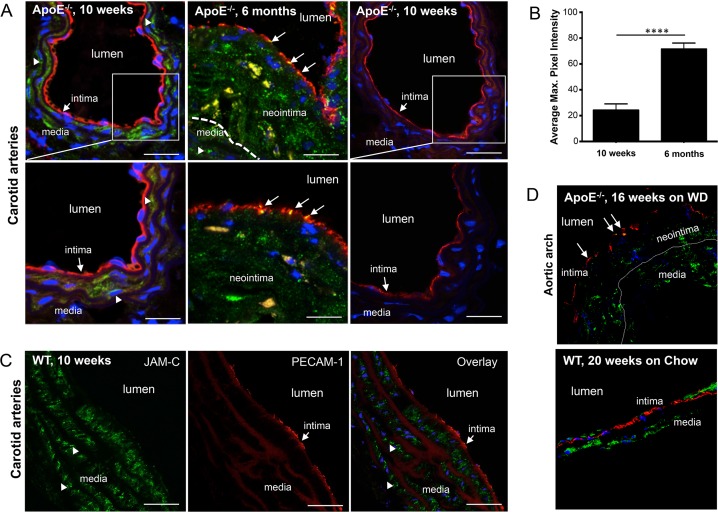
JAM-C expression in lesion-free and atherosclerotic carotid arteries.(A) Carotid artery sections of 10-wk old, lesion-free (left panels) and 6-mths old atherosclerotic ApoE-/- mice (middle panels) stained for JAM-C and PECAM-1 expression. JAM-C (green) and PECAM-1 (red) immunostaining of carotid arteries shows JAM-C expression on smooth muscle cells (arrowheads) and endothelial cells of carotid arteries of 6-mths old, atherosclerotic ApoE-/- mice (middle panels, arrows). No JAM-C staining was observed when an isotype control antibody was used (right panels). DAPI staining was used for nuclear counterstain (blue). Bars correspond to 100-um (upper panels); 200-um (lower panels). (B) Quantification of endothelial JAM-C expression of healthy (10 wks) and atherosclerotic carotid arteries (6 mths). Pixel intensity of endothelial associated JAM-C was measured using Fiji (ImageJ) software. Data presented as mean values ±SEM. (C) JAM-C expression in wild-type carotid arteries. Carotid artery sections of 10-wks old wild-type C57BL6/J mice stained for JAM-C and PECAM-1 expression. JAM-C (green) and PECAM-1 (red) immunostaining of carotid arteries shows JAM-C expression only on smooth muscle cells (arrowheads) and not endothelial cells (intima, arrows). Bars correspond to 100-um. (D) JAM-C expression in lesion-free and atherosclerotic aortic arches. Aortic arch sections of 16-wks old, atherosclerotic ApoE-/- mice fed on Western-type diet (WD, left panel) and 20-wks old, lesion-free WT mice fed on normal chow diet (Chow, right panel) stained for JAM-C (green) and PECAM-1 (red) expression. JAM-C expression on endothelial cells of neointima in aortic arches of atherosclerotic ApoE-/- mice (left panel, arrows). DAPI staining was used for nuclear counterstain (blue). Bars correspond to 100-μm. Images are representative of multiple stains done in at least two separate mice.